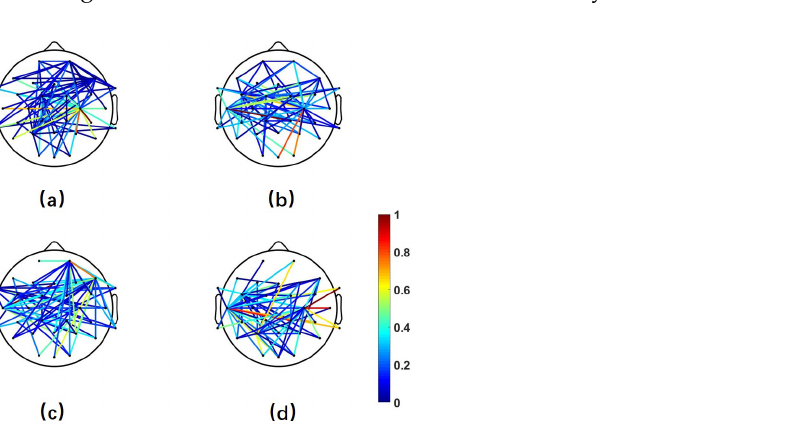
Figure 4. The brain connection networks of a subject when listening to piano music with 0 ( a ), 1 ( b ), 4 ( c ) and 5 ( d ) noise